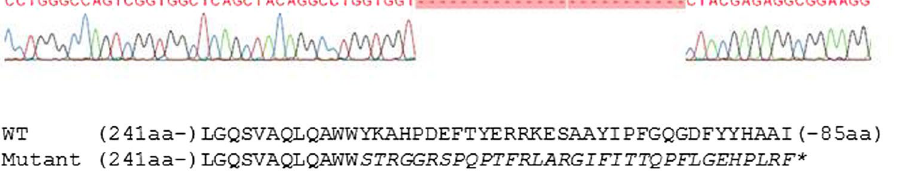
Figure 1. Targeting of GGTA1 in WT pig fetal fibroblasts using Fok I-dCas9. ( A ) Target region within GGTA1 exon 9. Green arrows indicate target sites for guide RNAs GT-3 and GT-4. Red arrowheads indicate binding sites for primers GTFS-F1 and GTFS-R1, used to amplify the target region after genome editing. ( B ) Flow cytometric analysis of α Gal expression (IB4-FITC) on fibroblasts, three days after co-transfection with expression vectors for Fok I-dCas9, GT-3 and GT-4. A substantial proportion of the co-transfected cells (red line) showed a marked reduction in α Gal expression compared to control vector-transfected cells (blue line); black line, unstained WT fibroblasts. ( C ) Sequence analysis of the target region, amplified from genomic DNA isolated from the pool of co-transfected cells. One clone contained a 25 bp deletion around the predicted cleavage site (arrowhead). The predicted amino acid sequences of WT and mutated α 1,3-galactosyltransferase are shown below the sequence, indicating an altered stretch of 33 residues (italics) and truncation of 85 residues in the mutant